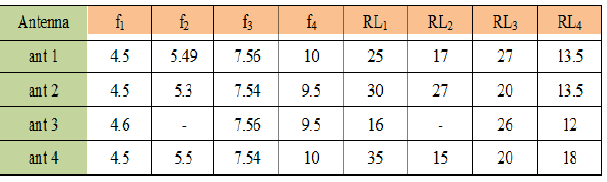
Table 2: Simulated results of the proposed quadruple-band microstrip